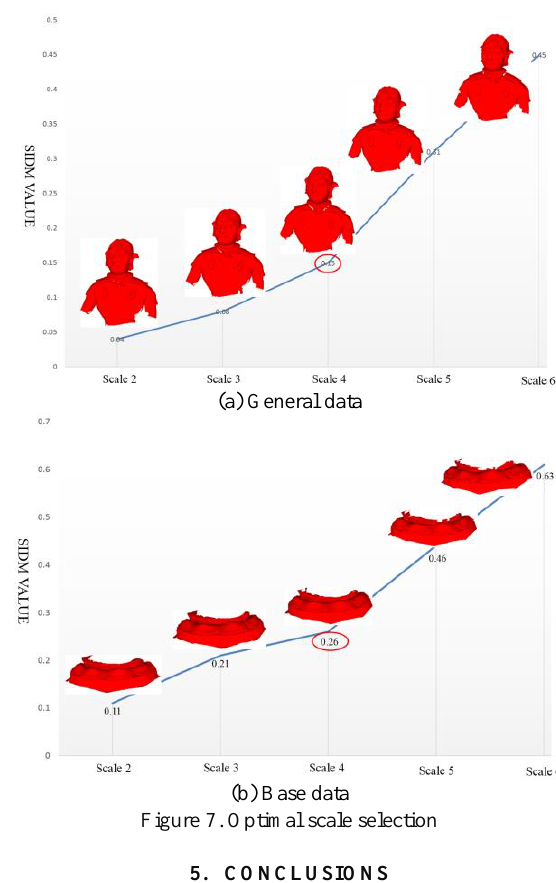
Figure 7. Optimal scale